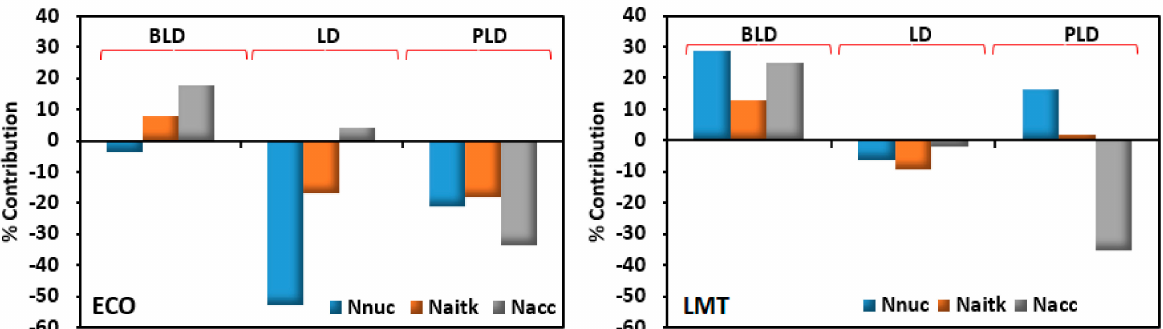
Figure 3. Percentage variation ratio for both sites, ECO and LMT, during the three time windows for each size class: N nuc (Dp < 20 nm), N aitk (20 nm < Dp < 100nm) and N acc (100 nm < Dp < 800